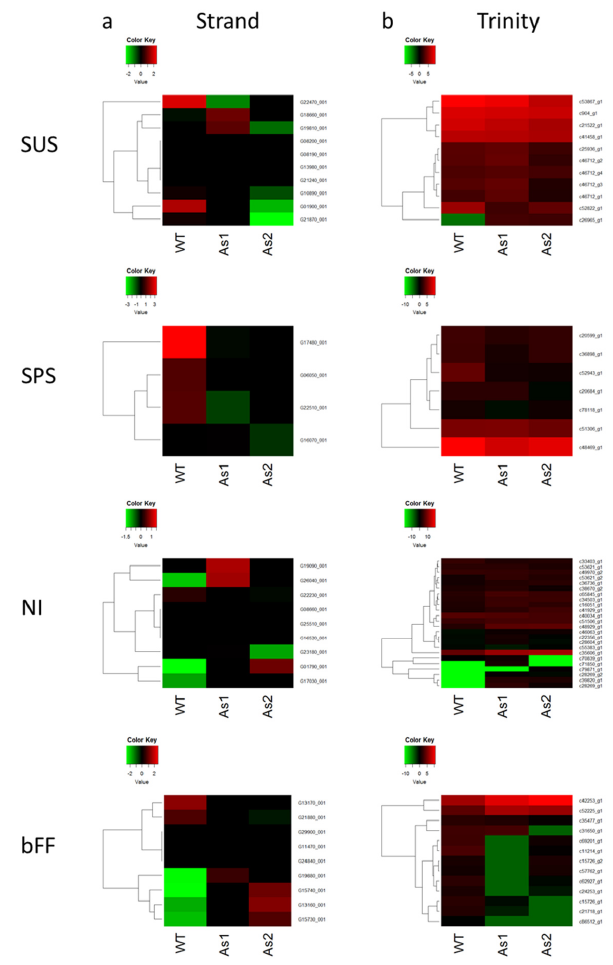
Figure 3. Differentially expressed genes of sucrose synthase (SUS), sucrose phosphate synthase (SPS), neutral invertase (NI), and acidic invertase/ β -fructofuranosidase (bFF) in Mh-ACO1 RNAi (As1), Mh-ACO2 RNAi (As2), and the control (WT) banana plants. The analyzed softwares are Strand NGS software package (Avadis) ( a ) and Trinity package ( b ). To highlight the relative differences between plants, log2 transformed fold change values for each contig are displayed. The detailed data are given in Tables S2 and S3.